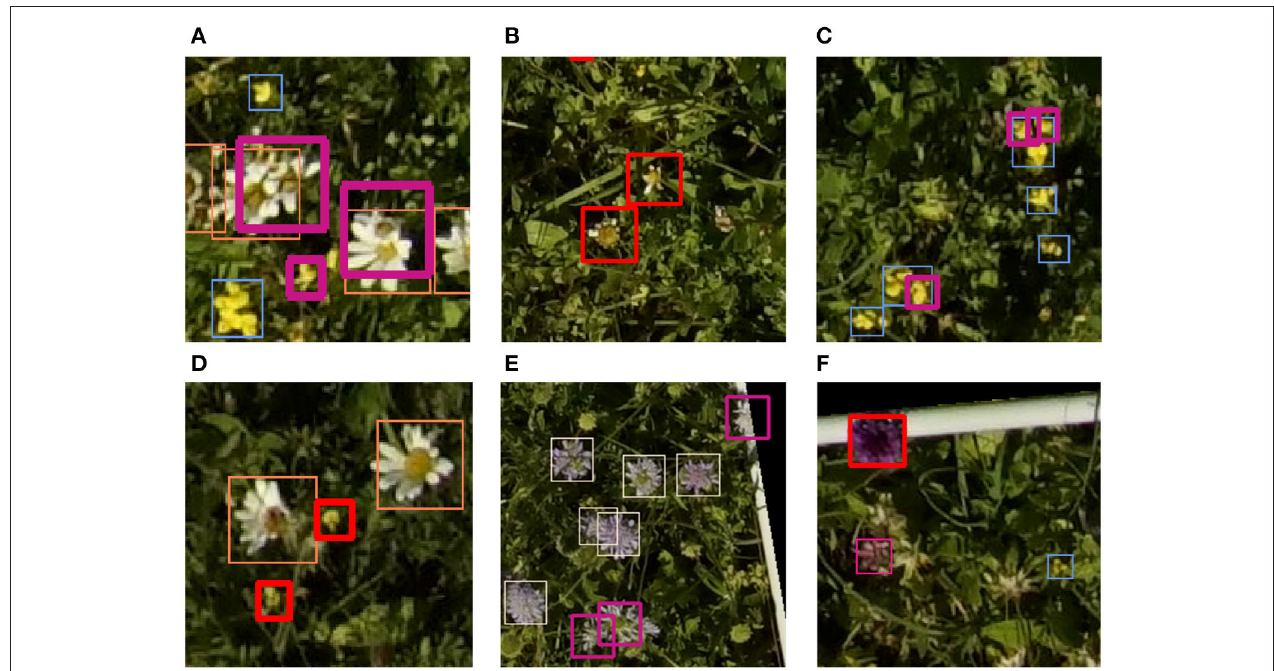
FIGURE 4 | Selection of typical mispredictions. All thin bounding boxes are correct predictions. The bold red bounding boxes denote false positive and the bold violet bounding boxes denote false negative predictions. There are various explanations for the mispredictions: Overlapping flowers (A) , partially withered flowers (B,E) , collections of flowers (C) , missing ground truth annotations (D) and flowers that are missing in the training data (F) .